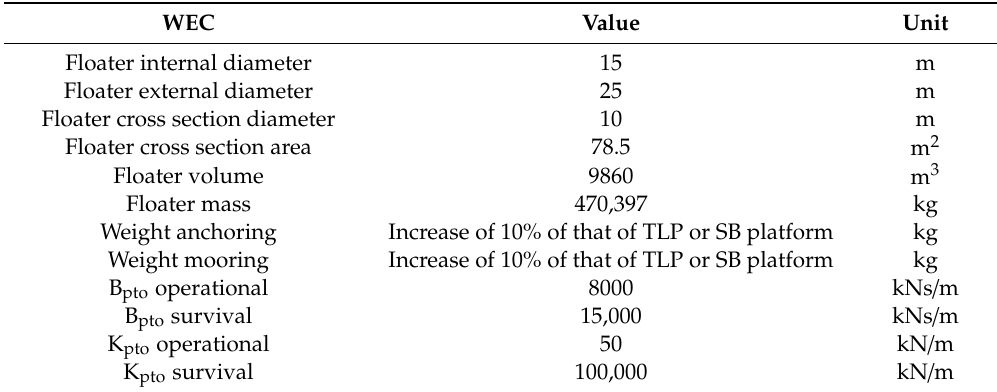
Table 3. WEC structural